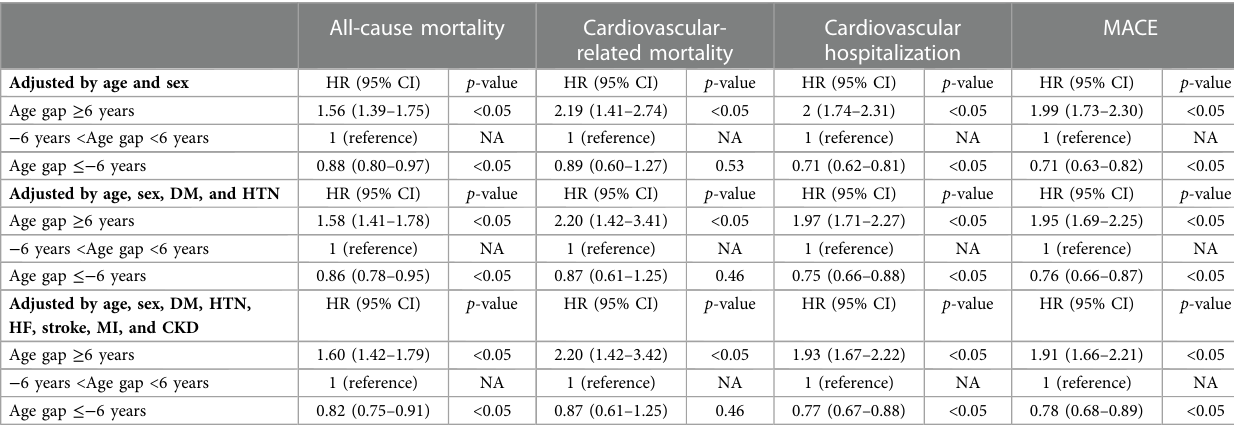
TABLE 2 Hazard ratios of clinical outcomes.